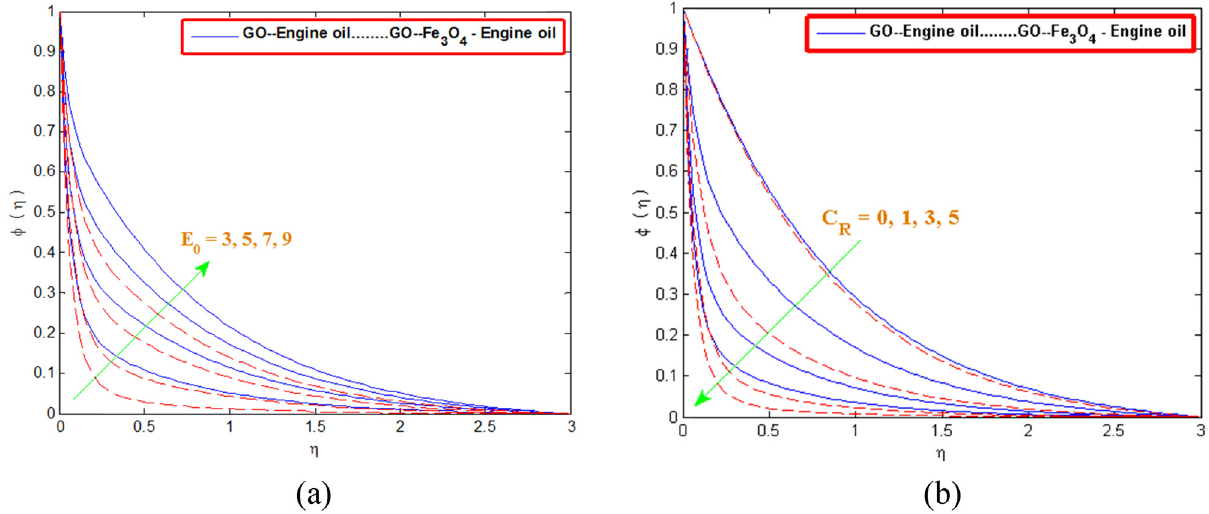
Figure 8: Change in concentration with ( a ) chemical reaction parameter and ( b ) activation